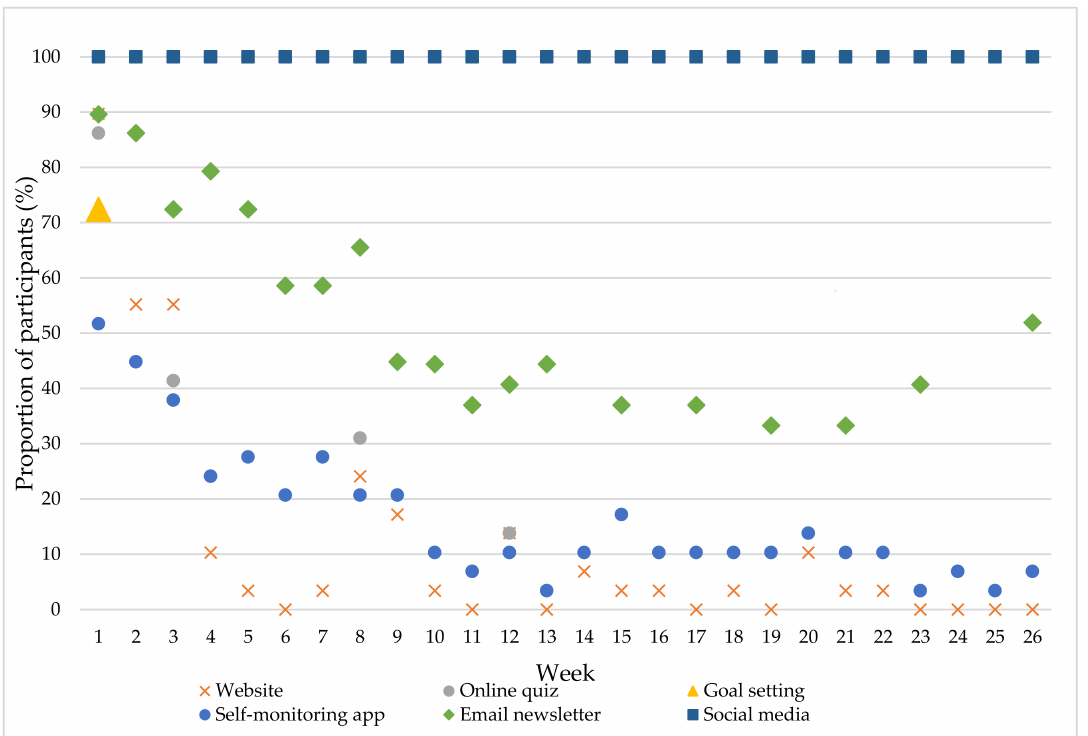
Figure 2. Proportion of participants who ‘engaged’ with each Be Positive Be Health e program component from Weeks